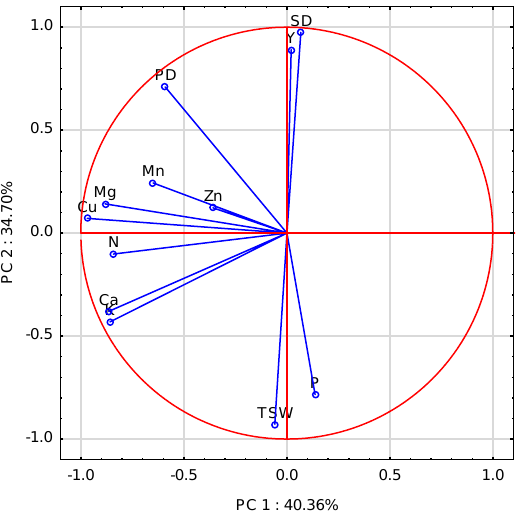
Figure 5. Score plot of WOSR components and a particular Nutrient Remobilization Quota in PC1 and PC2 axes. Y—Yield, SD—Seed Density, PD—Pod Density, TSW—Thousand Seed Weight, N, P, K, Mg, Ca, Mn, Zn, Cu — nutrients.